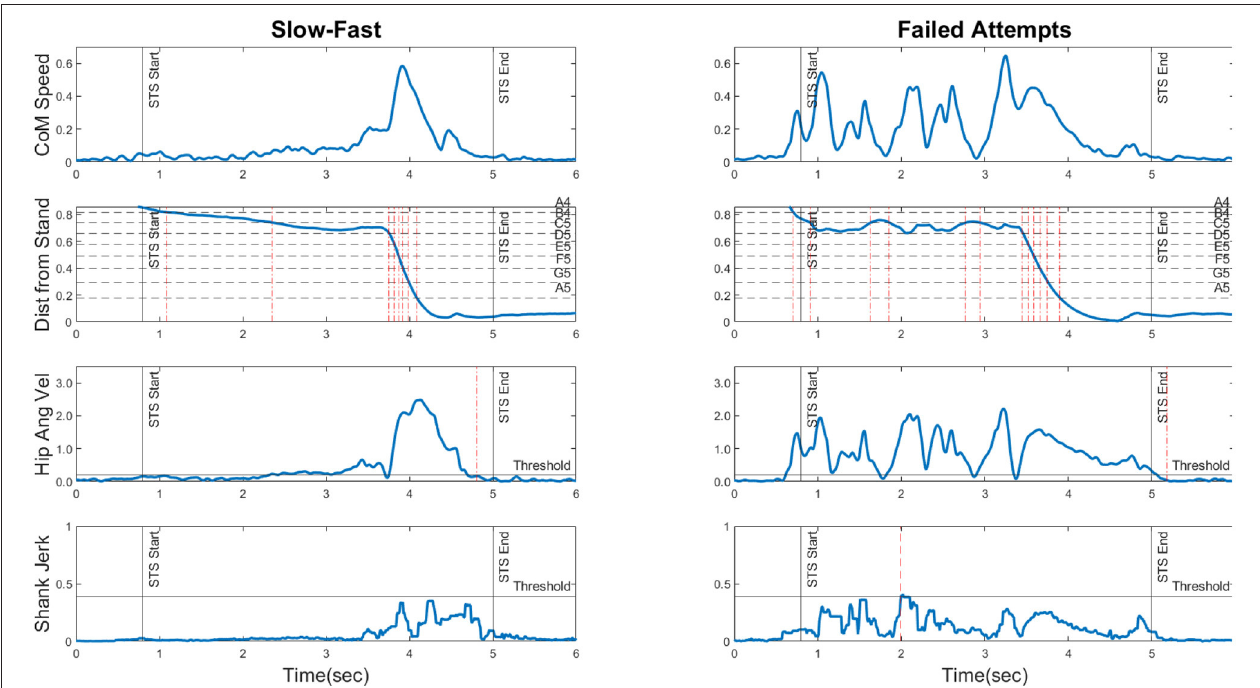
FIGURE 1 | The four movement features (rows) plotted for two movement patterns (Slow-Fast and Failed Attempts) to illustrate their information content. The horizontal axis is time in seconds. ROW 1: CoM Speed shown in bodylengths / s . ROW 2: Distance from Stand shown as a fraction of the distance between the sit and stand coordinates. The horizontal dotted lines represent the distance thresholds corresponding to each note in the melodic pitch mapping (see Section 3.4). The vertical dashed-dotted lines represent instants of note transitions, providing a picture of the generated melodic contour. ROW 3: Hip Angular Velocity shown in degrees / s , and if it remains below the threshold for 130 ms consecutively, a freeze registered. Detected freezes are shown as vertical dotted lines. ROW 4: Shank Jerk shown as degrees / s 3 . The horizontal line “Threshold” represents the maximum permissible jerk threshold. The dashed lines represent positive threshold crossings. For corresponding plots of all six STS patterns, please refer to the Supplementary Material